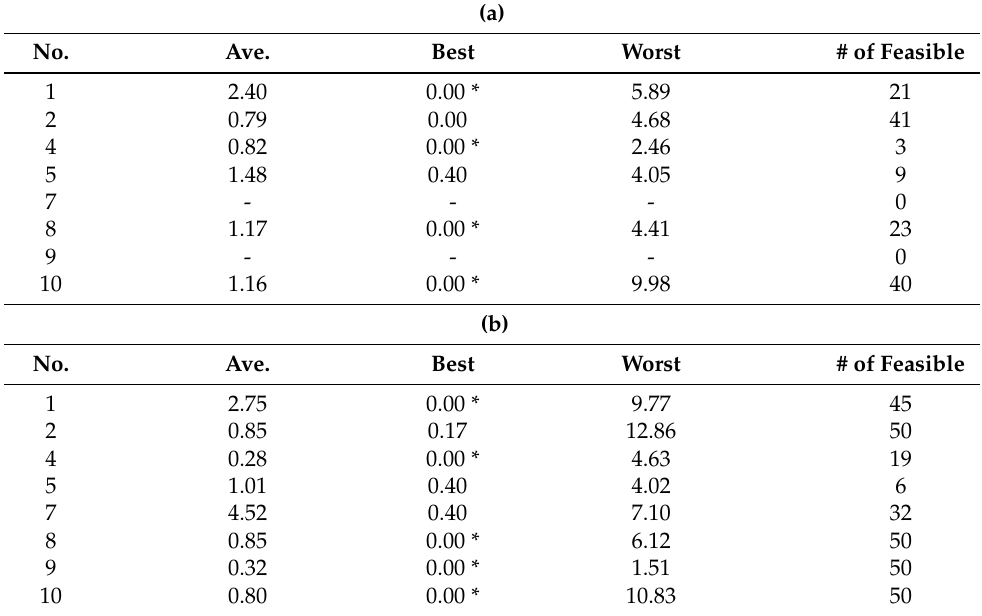
Table 5. Results of the method using fixed values of weight parameters for n = 30. Symbol “-” means that no feasible solutions can be obtained. Feasible solutions of instances 3 and 6 cannot be found by the latest version of the Gurobi optimizer 9.1.1 within 12 h. Symbol “*” means that an optimal solution can be obtained using the Gurobi optimizer 9.1.1 within 12 h. ( a ) α = 200, β = 2000. ( b ) α = 1000, β = 10,000.